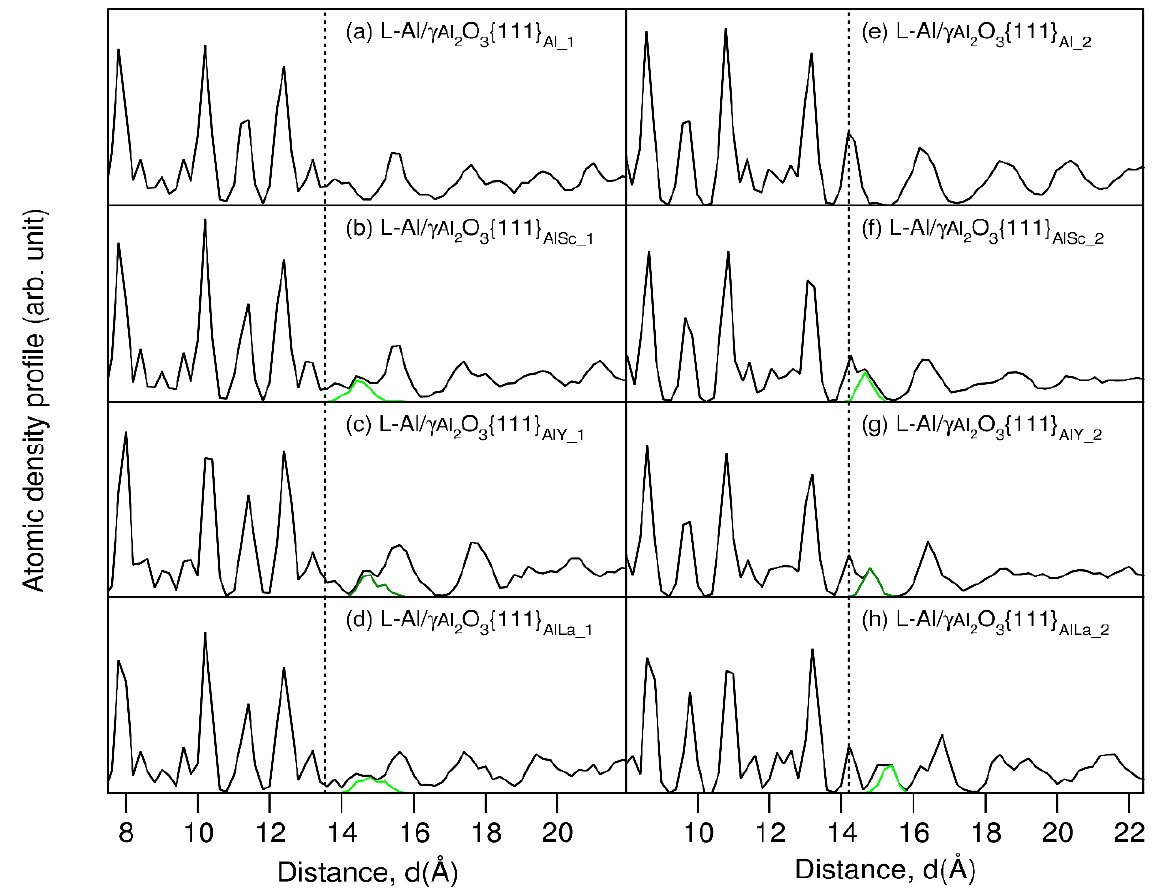
Figure 2. Atomic density profiles for the Al( l )/ γ -Al 2 O 3 {1 1 1} AlM systems equilibrated at 900 K. The black curves are for all atoms and the colored curves are for the Group 3 atoms. The vertical dotted lines represent the terminating metal layer. The segregation of the Group 3 atoms broadens the ter- mination metal layers at Al( l )/ γ -Al 2 O 3 {1 1 1} AlM_1 and new peaks at Al( l )/ γ -Al 2 O 3 {1 1 1} AlM_2 , roughening the substrates’ surfaces. ( a ) Al( l )/ γ -Al 2 O 3 {111} Al_1 , ( b ) Al( l )/ γ -Al 2 O 3 {111} AlSc_1 , ( c ) Al( l )/ γ -Al 2 O 3 {111} AlY_1 , ( d ) Al( l )/ γ -Al 2 O 3 {111} AlLa_1 , ( e ) Al( l )/ γ -Al 2 O 3 {111} Al_2 , ( f ) Al( l )/ γ -Al 2 O 3 {111} AlSc_2 , ( g ) Al( l )/ γ -Al 2 O 3 {111} AlY_2 , ( h ) Al( l )/ γ -Al 2 O 3 {111} AlLa_2 .